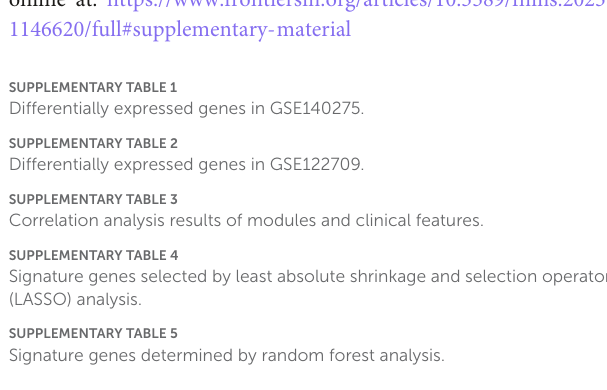
SUPPLEMENTARYTABLE3 Correlation analysis results of modules and clinical